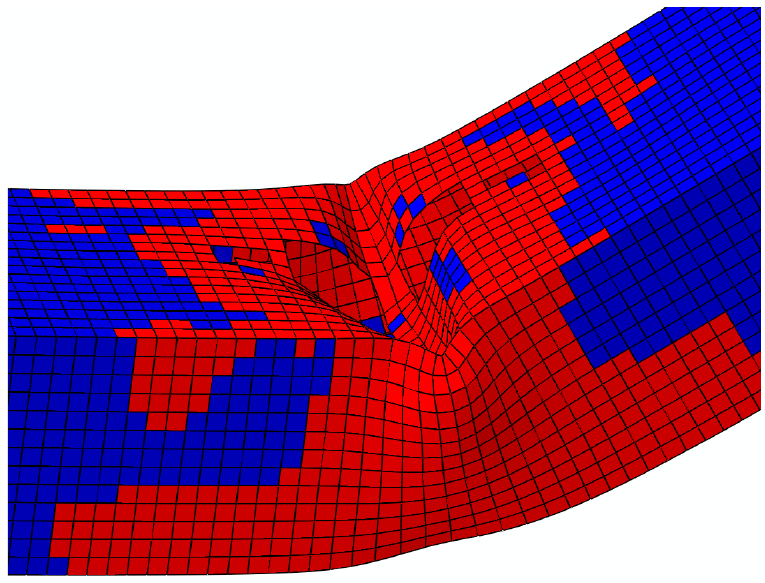
Figure 18. The failure mode of the G5-derived beam showing the minimum moment capacity.